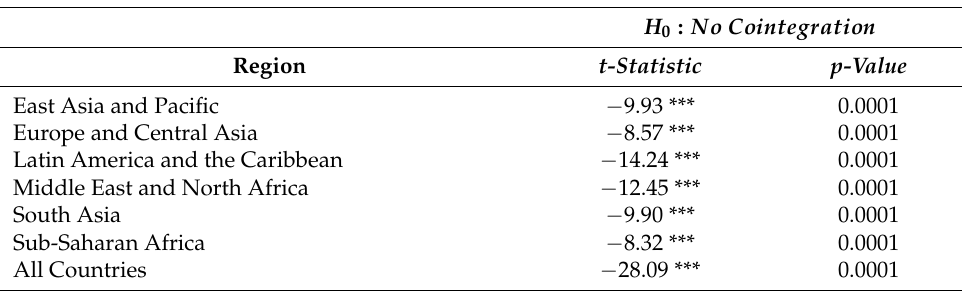
Table A2. Kao Residual Panel Cointegration